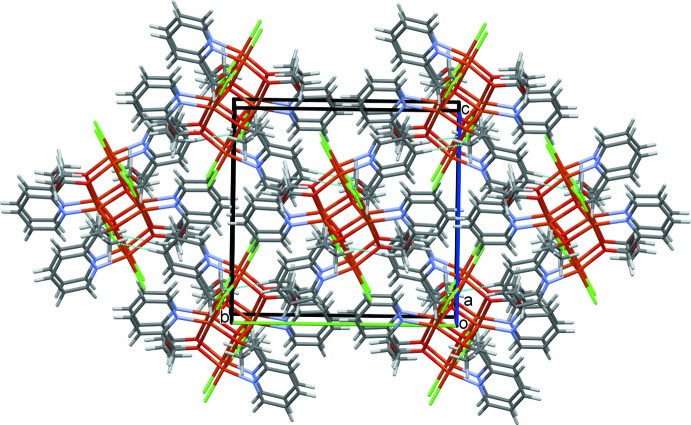
A view along the a axis of the crystal packing of II.